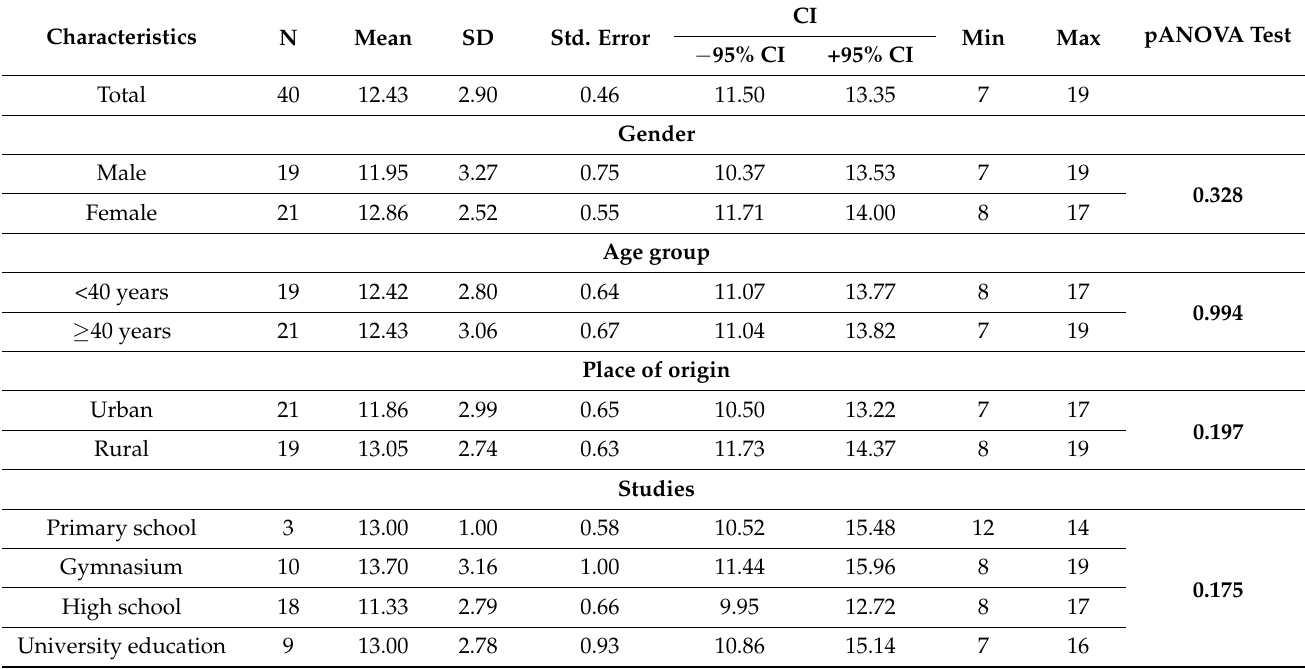
Table 4. Descriptive statistical indicators of the impact